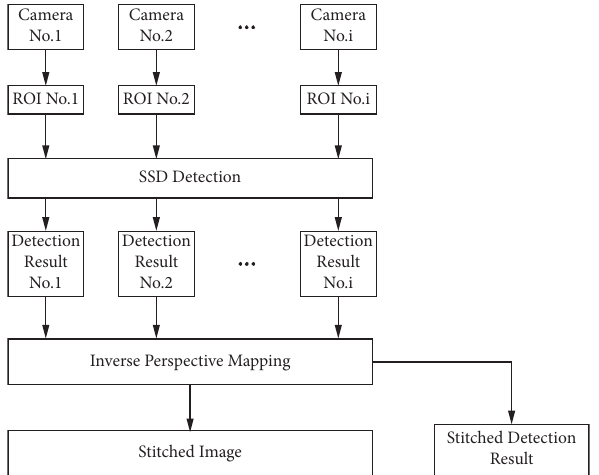
Figure 7: Detection process.